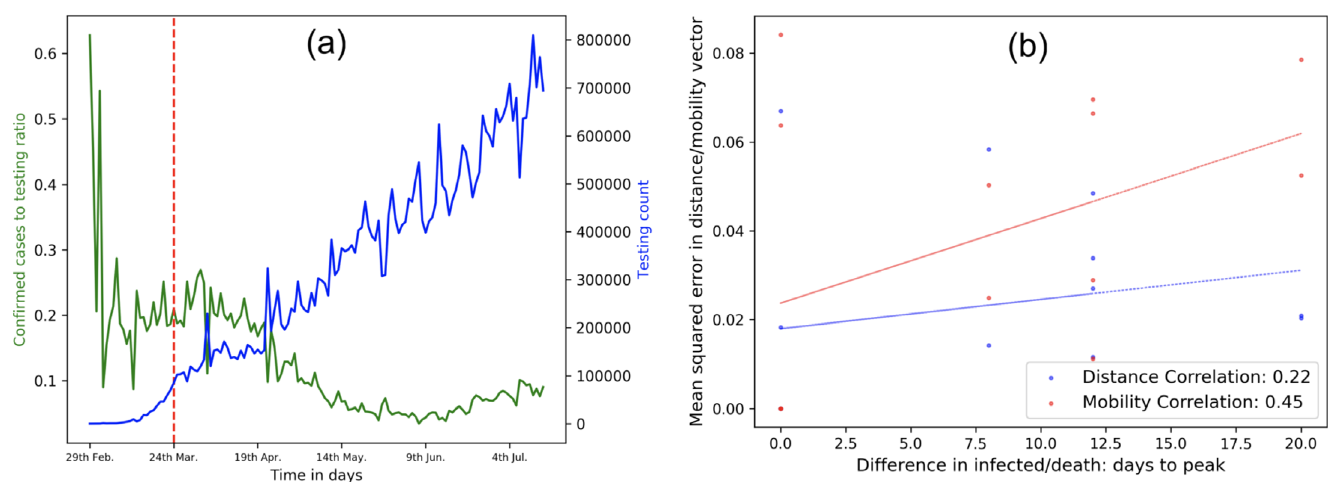
Fig 7. Role of mobility and testing on spread: (a) the effect of testing and lockdown on infection spread: Testing rate (blue line) increases steadily over time and confirmed cases to testing ratio drops post lockdown due to reduced contact; (b) correlation between mobility (or distance) and days for infected to peak in neighboring NYC boroughs.